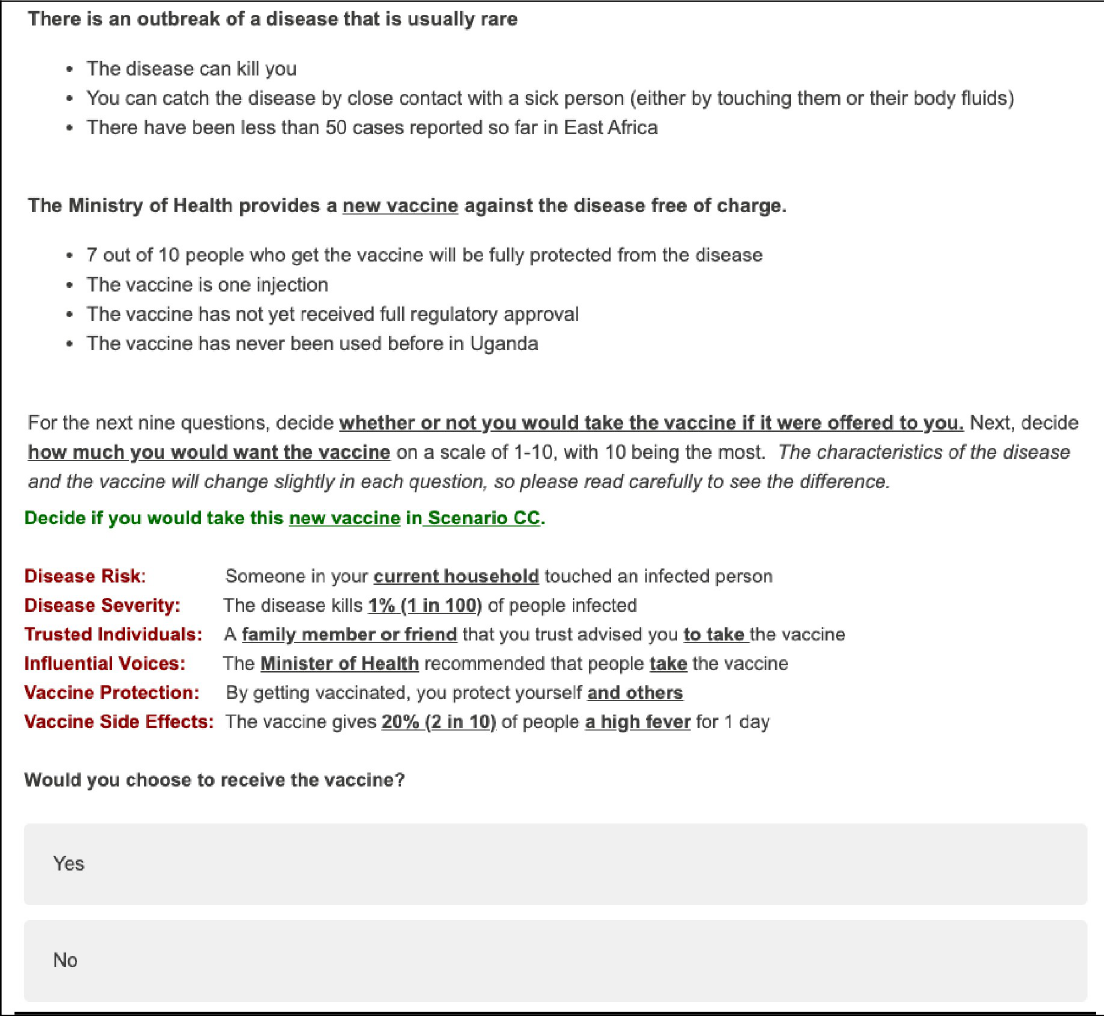
Fig 1. Example DCE scenario and DCE